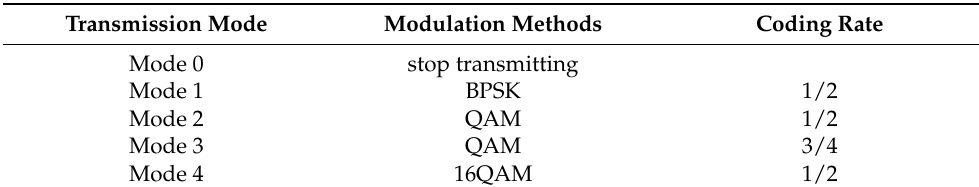
Table 2. Modulation and coding modes.